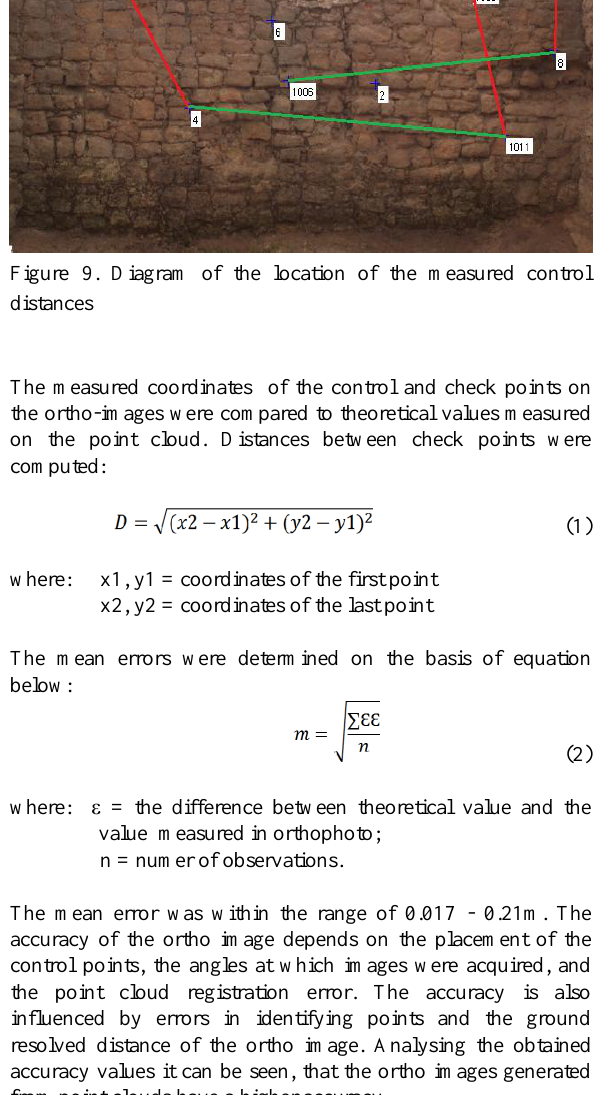
The accuracies of the generated ortho images had been determined based on a comparison between the theoretical distances between control points and check points and those same distanced on the ortho images (figure 9).